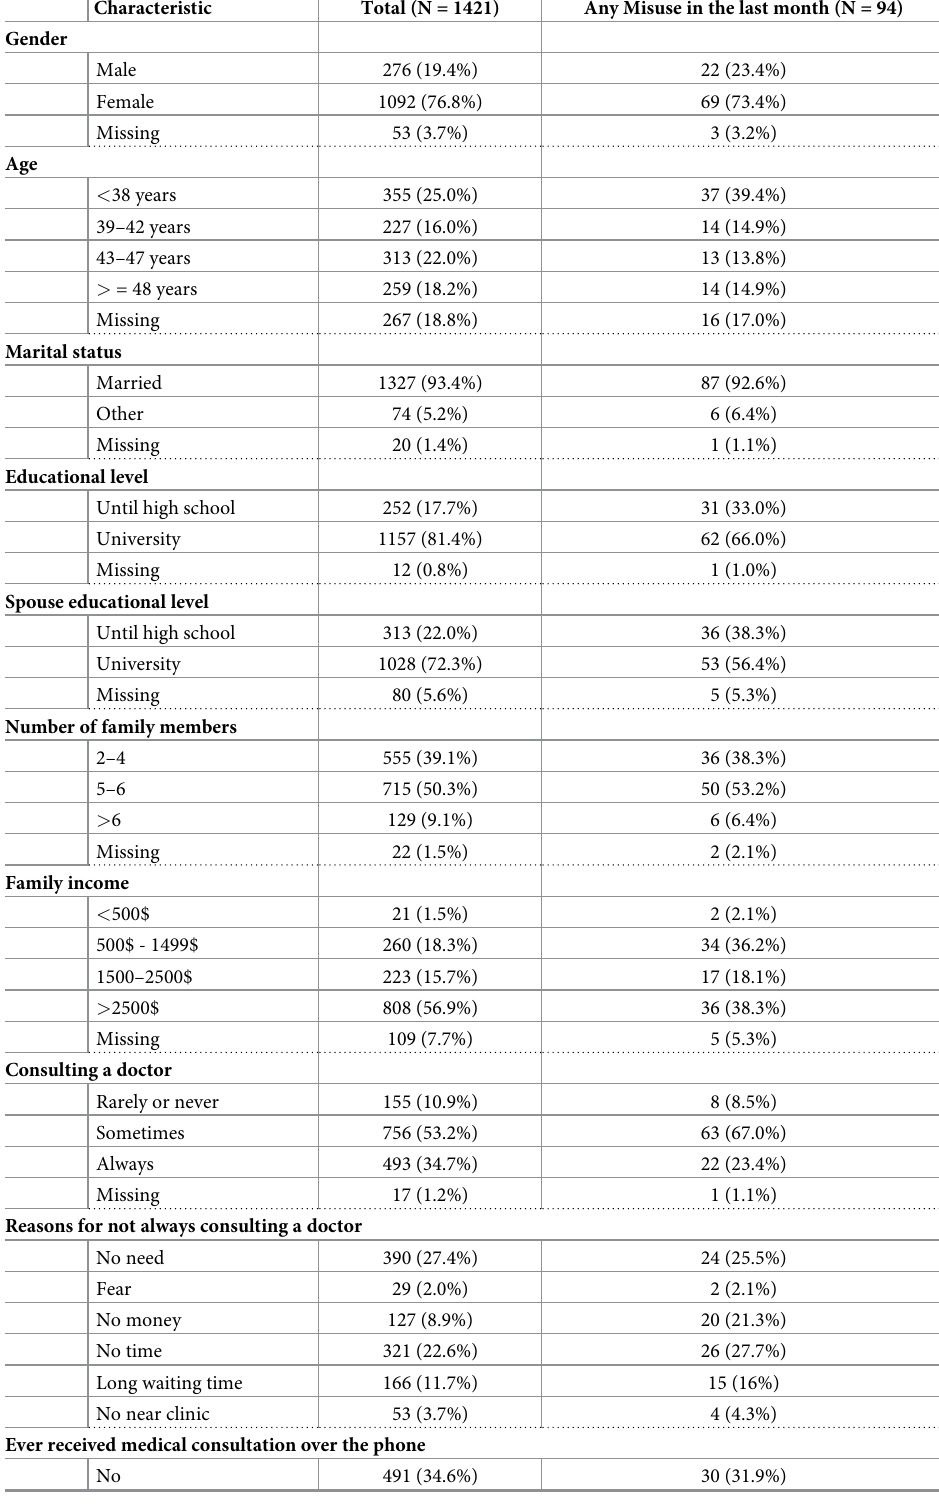
Table 1. Participants´ demographic